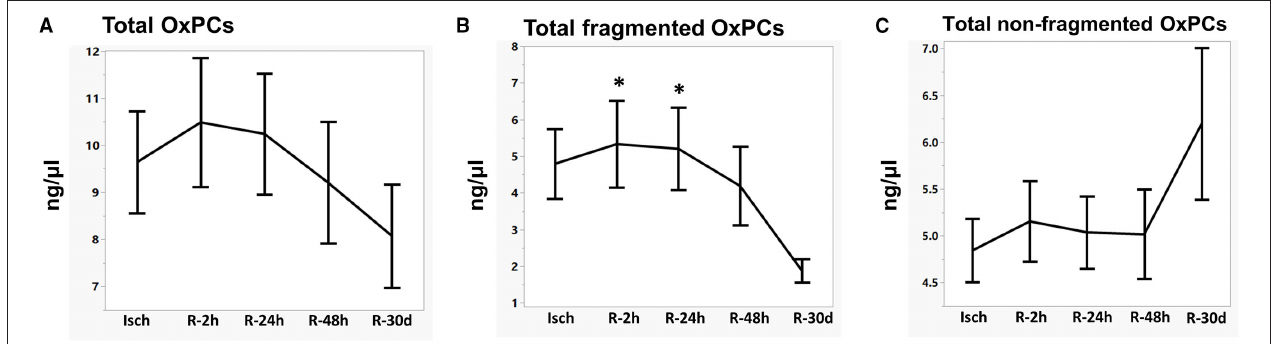
23% of all quantified OxPCs were aldo-OxPC and acid- OxPCs, respectively. Non-fragmented OxPCs constituted only